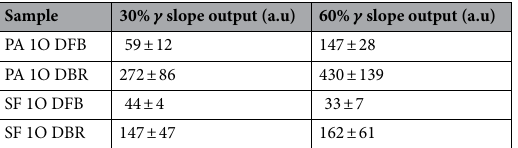
Table 1. Slope output efficiencies for PA, SF 1O DFB and DBR samples for 30, 60% γ .